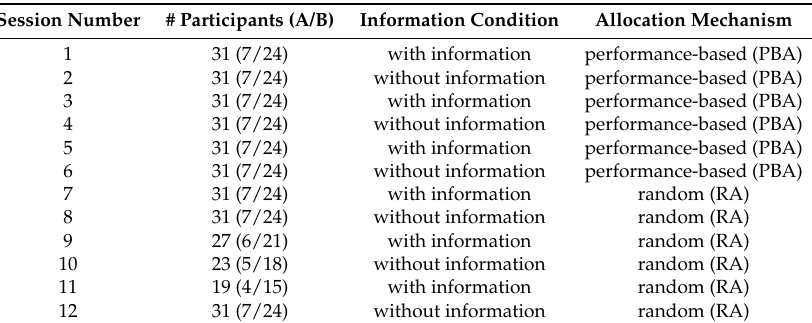
Table A1. Overview of experimental sessions.